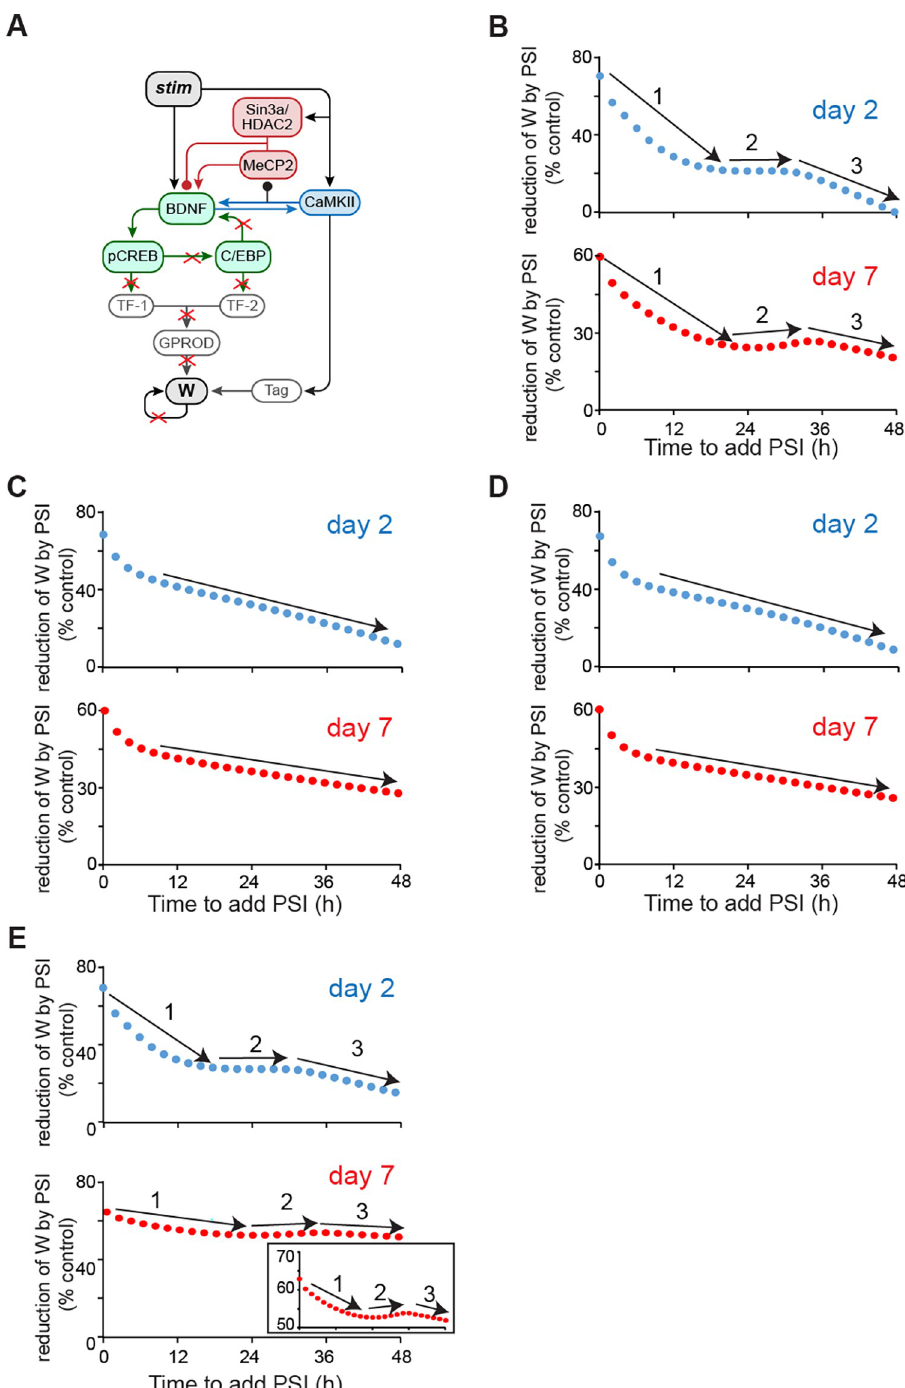
Fig 3. Simulated response to PSI. (A) Schematic model of the pathways that are blocked by PSI (red X’s). (B) Reduction of synaptic weight W at day 2 (blue curve) and 7 (red curve) after training, with the addition of PSI initiated at varying times. ‘1’,’2’,’3’ represent different phases. (C-D) Simulated reduction of W response to PSI in the absence of the BDNF-CaMKII α feedback loop (C) or of the BDNF-C/EBP β feedback loop (D) or of the downstream W loop (E) at day 2 (blue) and day 7 (red). Insert in (E), same as main panel except Y axis scale is expanded to more clearly illustrate vertical variations in W.